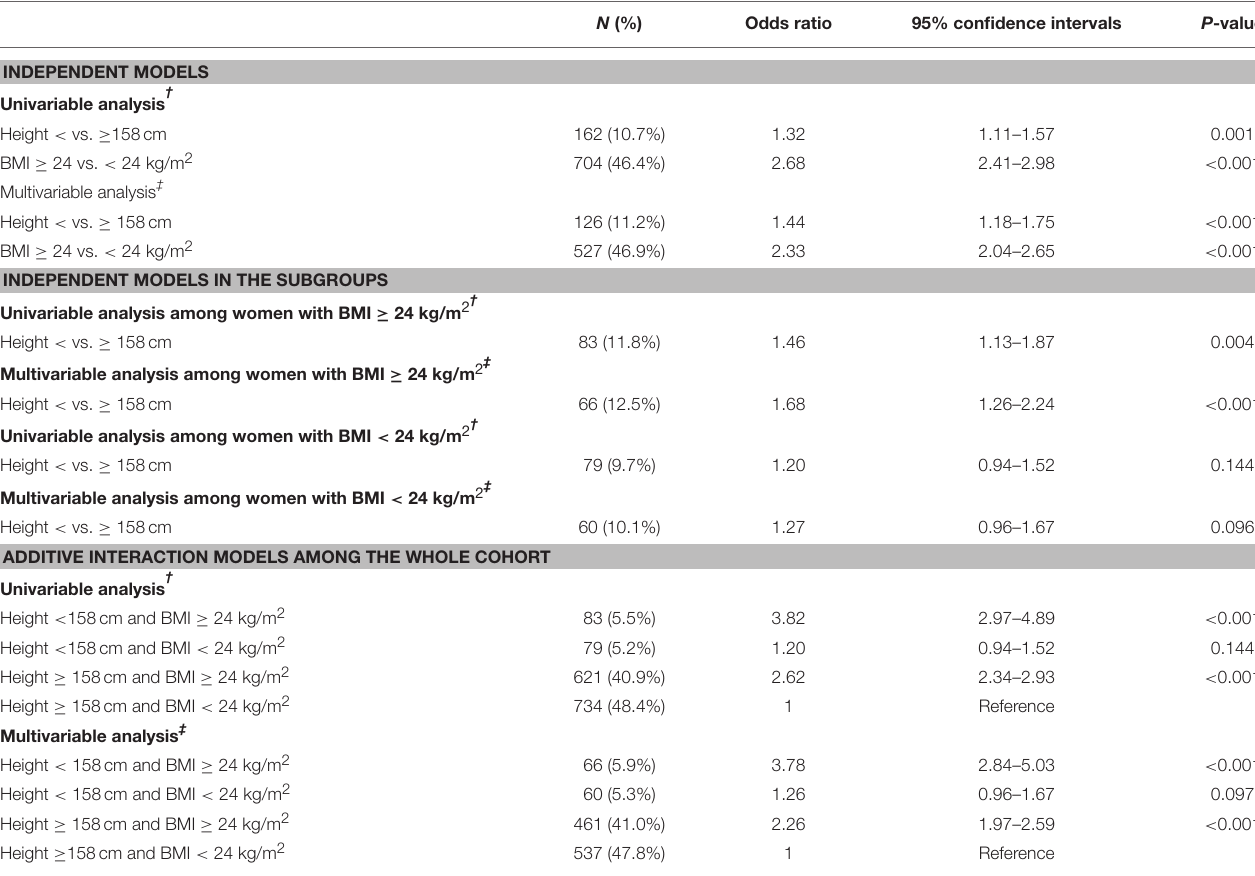
TABLE 2 | Odds ratios (ORs) of short height and pre-pregnancy BMI for the risk of gestational diabetes mellitus. N (%) Odds ratio 95% confidence intervals P